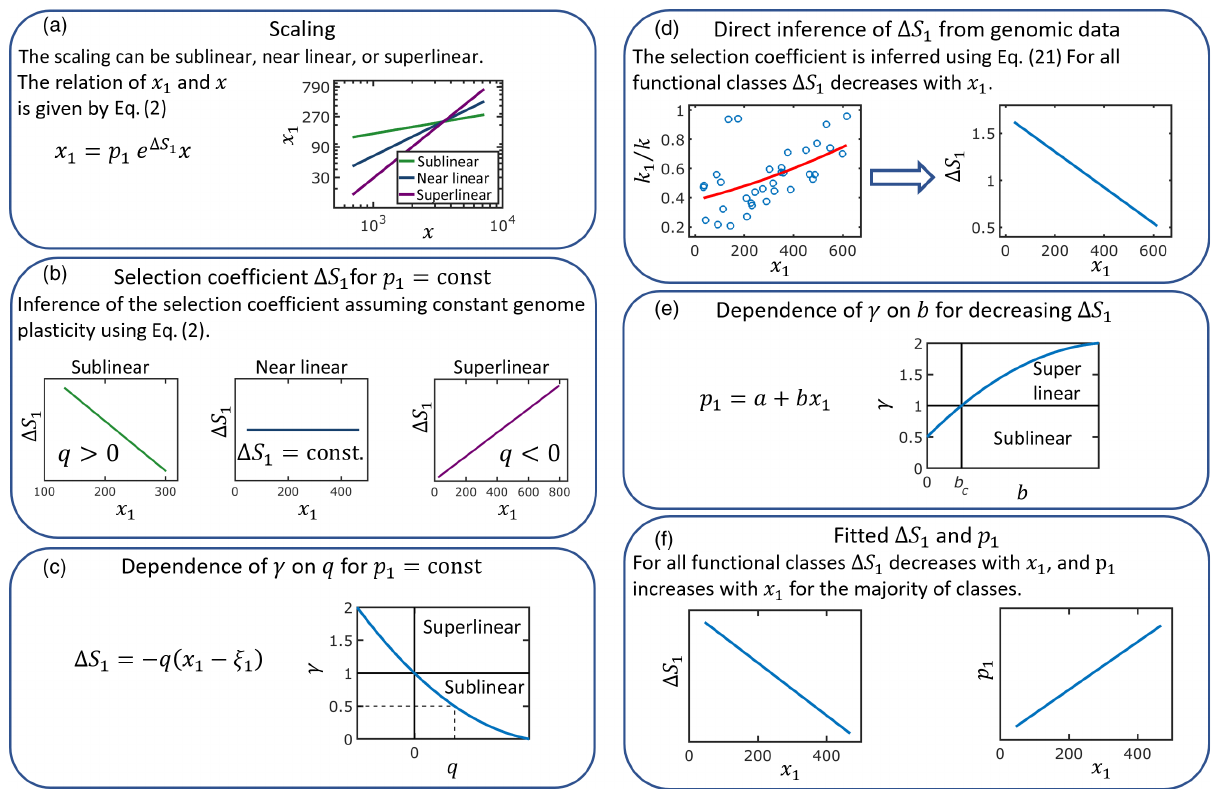
FIG. 5. Visual representation of model scaling according to Eq. (2). The figure presents an outline of the model analysis demonstrating the emergence of genome plasticity. The class-specific selection coefficient Δ S 1 , which is inferred from the genomic data, implies class- specific genome plasticity that depends on the number of genes in the given class p 1 ¼ p 1 ð x 1 Þ . (a) An illustration of the scaling of the number of genes in functional classes with the total genome size. Three representative cases are illustrated: sublinear, near-linear, and superlinear scaling. (b) For constant genome plasticity, the scaling is determined by the selection coefficient. Three selection coefficients corresponding to the three scaling exponents in (a) are shown. The sign of q [see Eq. (18)] is indicated for each case. (c) Schematic illustration of the dependence of the scaling exponent γ on q , as implied by Eq. (2). For the constant selection coefficient, the scaling is linear ( γ ¼ 1 ). The value of q that corresponds to (e) is indicated by a dashed line. (d) For all functional classes, q is positive such that the selection coefficient decreases with x 1 . (e) Schematic illustration of the dependence of the scaling exponent γ on the plasticity slope b [see Eq. (19)] under a positive q value [see (c)]. For b ¼ 0 , the scaling is sublinear, with a γ value identical to the value indicated by a dashed line in (c). For large enough b values, the scaling turns from sublinear to superlinear (indicated by black lines). (f) Illustration of the inferred class-specific selection coefficients and genome plasticity. For all functional classes, the selection coefficient decreases with the genome size, whereas genome plasticity increases with the genome size for the majority of the